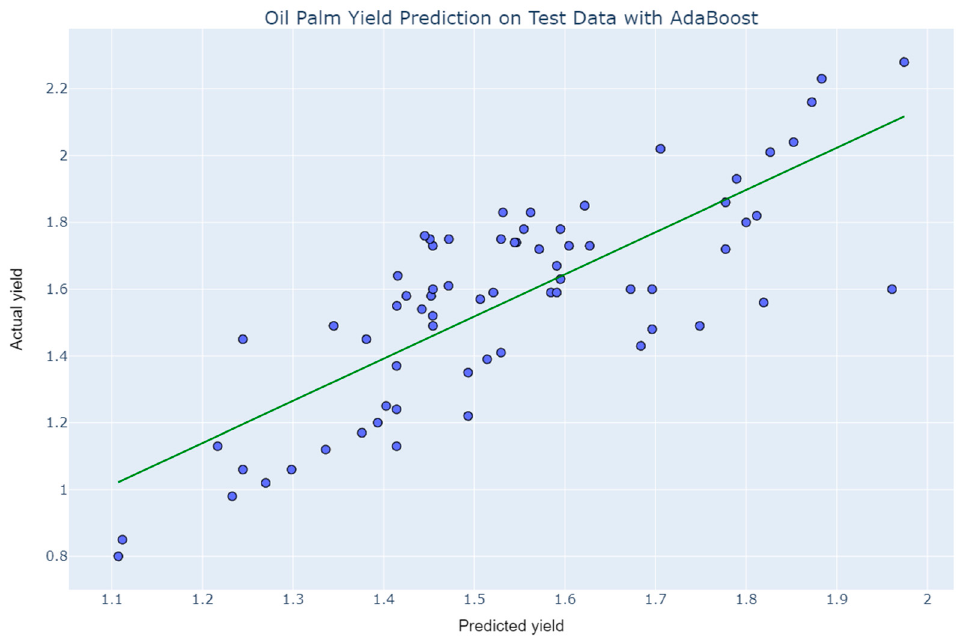
Figure 13. Prediction of oil palm yield by AdaBoost.